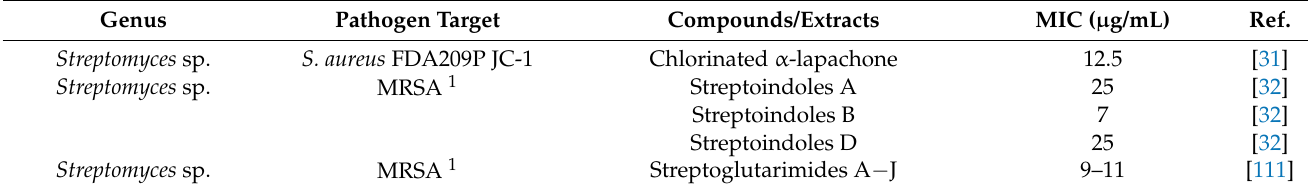
Table 2. Antimicrobial activity of actinobacterial crude extracts or